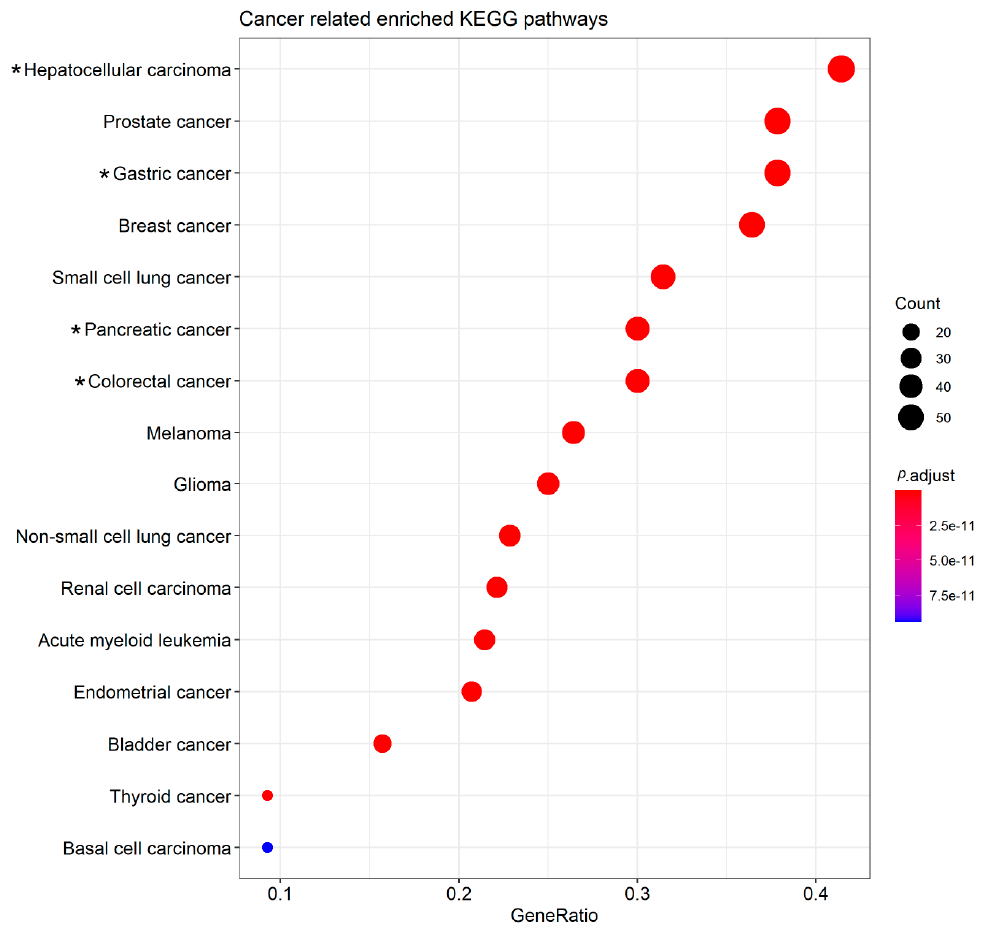
Figure 3. Cancer KEGG pathways in which the sponged miRNAs’ target genes are potentially involved. (*) Gastrointestinal tumors.